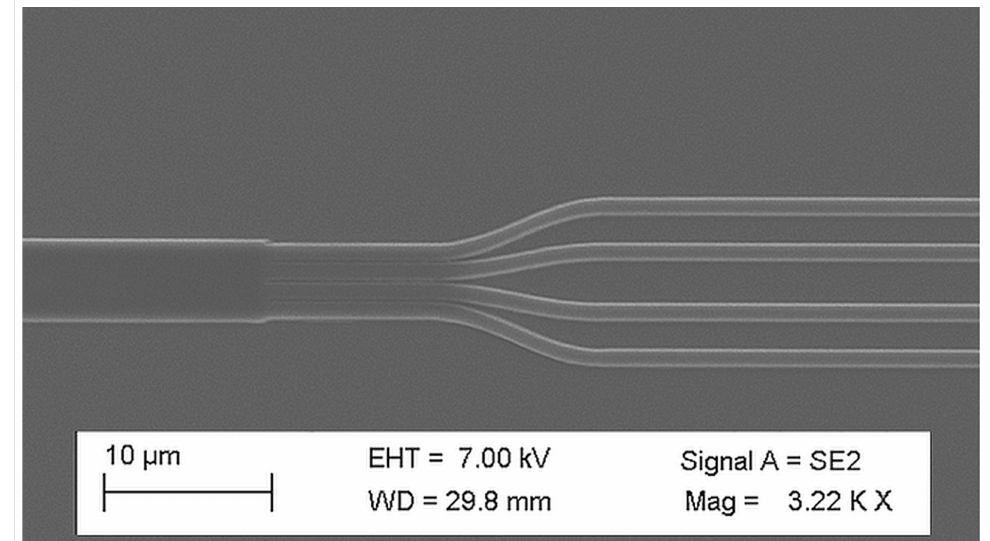
Figure 21. SEM image of 1 × 4 MMI designed for λ = 660 nm with visible closely placed output WGs.